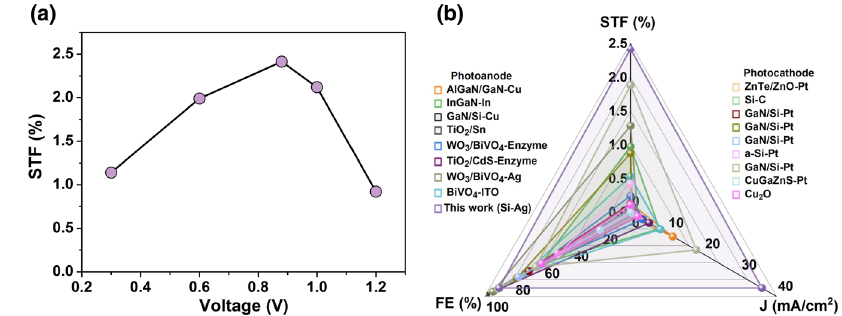
Fig. 5 | Calculation and comparison of STF ef fi ciency. a STF ef fi ciency of PEC Si photoanode for the conversion of CO 2 to CO and b Performance comparison of photoanodes and photocathodes promoted cell for PEC CO 2 RR. Chart visualizing